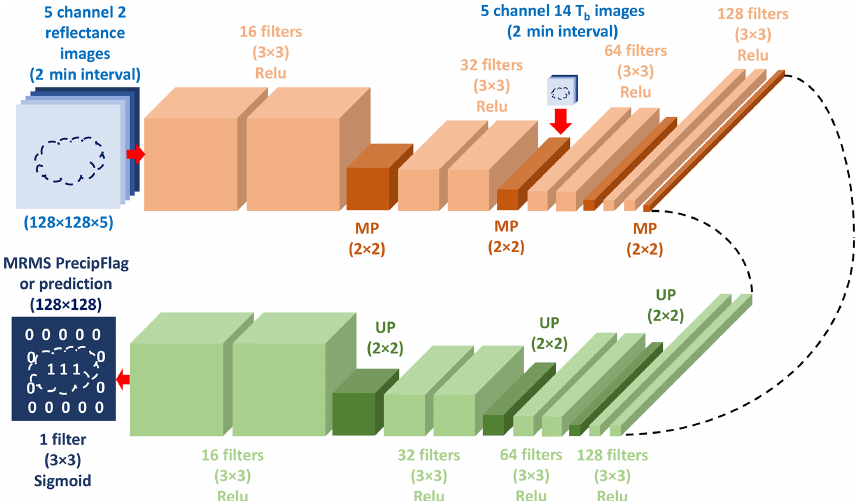
Figure 1. Description of the encoder–decoder model; 3 × 3 represents the dimensions of a filter used in convolutional layers. MP refers to the maxpooling layer, and UP refers to the upsampling layer, both with a window size of 2 × 2. Starting from five channel 2 images (upper left), the encoder section is presented in the upper row, with the additional five channel 14 images entering after the second maxpooling layer. The decoder section is shown in the lower row from right to left, with the output layer at the end (lower